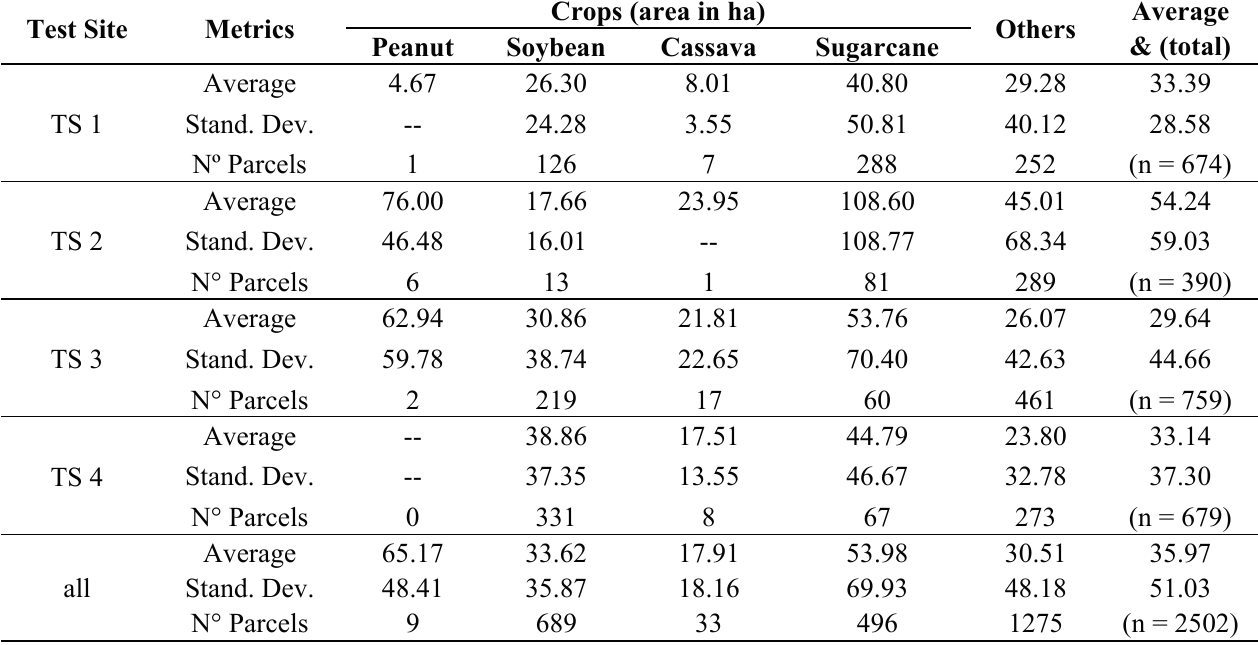
Table 4. Descriptive summary of reference information collected within four test sites (TS1 to TS4). Numbers to which we refer in the text are highlighted. The reported statistics relate to individual polygons. Polygons were manually digitized and visually interpreted. All areas are in